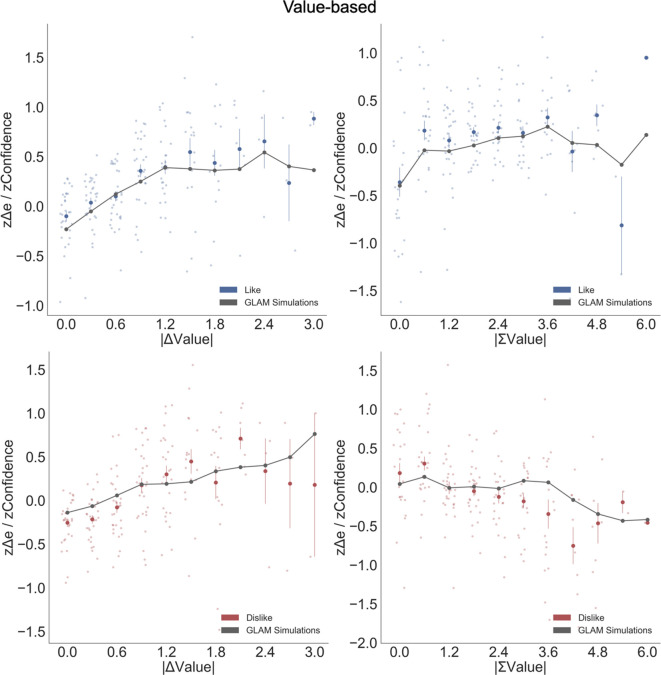
Balance of evidence simulations in the Value Experiment.The difference between accumulators (Δe) obtained from GLAM simulations matches participants’ confidence. Top left: a higher value difference between the two items (|ΔValue|) increases confidence and simulated Δe. Top right: in the like frame, an increase in the summed value of the two alternatives (|ΣValue|) boosts confidence and simulated Δe. Bottom left: as in like frame, |ΔValue| boosted confidence and Δe in dislike frame. Bottom right: in the dislike frame, the effect of |ΣValue| over confidence flips: confidence and Δe decrease with higher values of the alternatives, accounting for the change in goal. Blue and red dots depict the (z-scored) confidence taken from participants in like and dislike frames (respectively). Grey line presents the model simulations for both separate frames. Data were segmented in 11 bins for ΔValue or ΣValue.